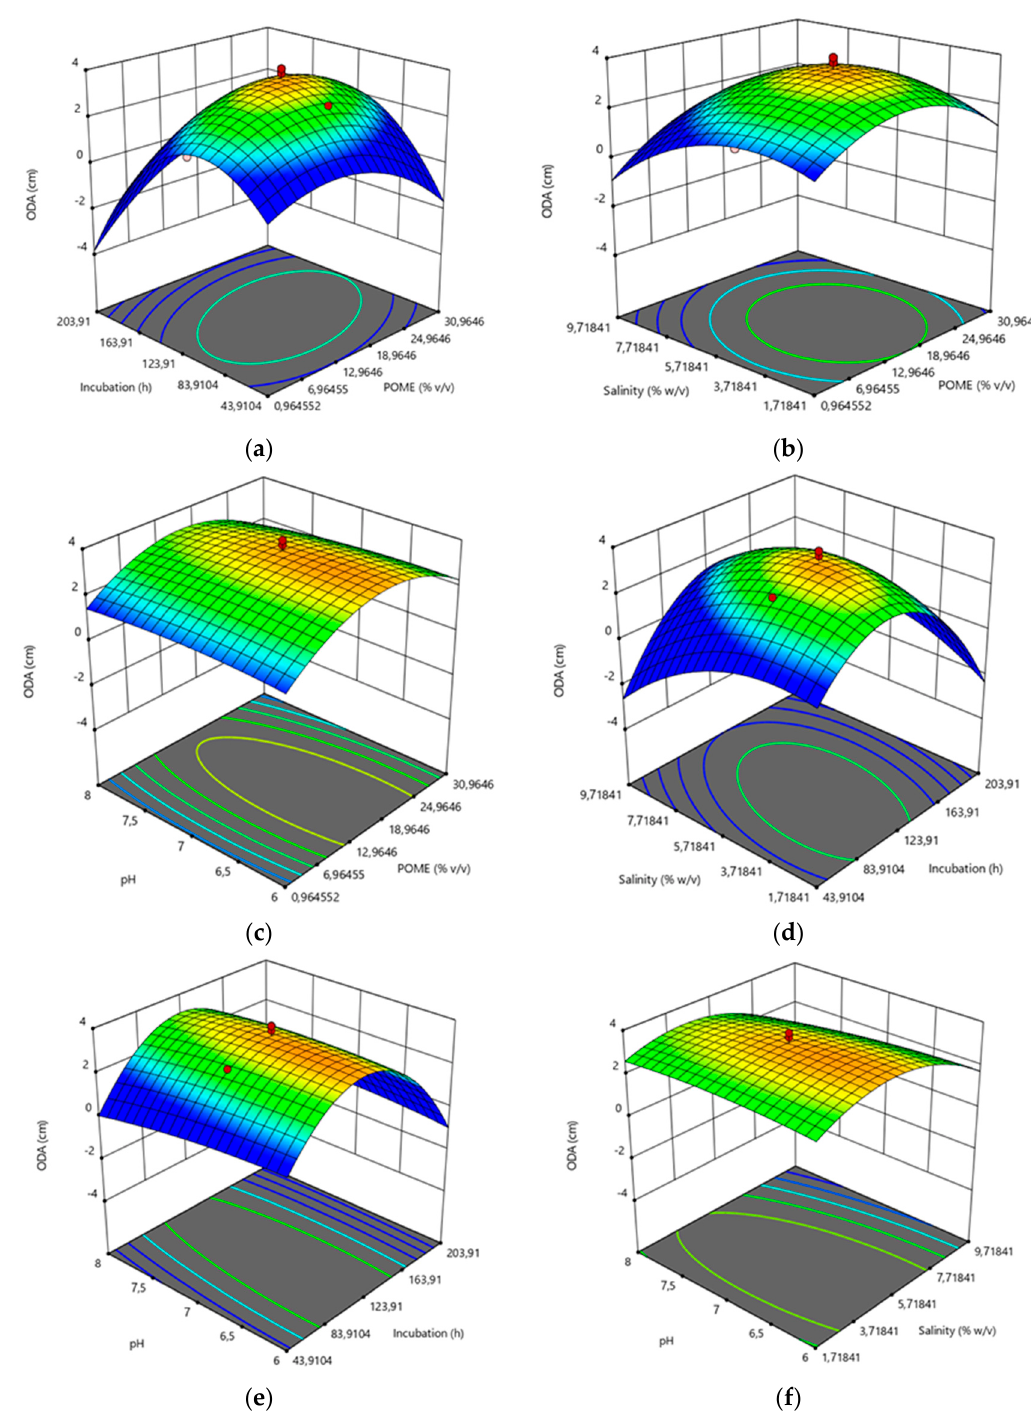
Figure 3. Intervariable relationship in RSM oil displacement area response. ( a ) Incubation and POME concentration, ( b ) NaCl concentration and POME concentration, ( c ) pH and POME concentration, ( d ) NaCl concentration and incubation, ( e ) pH and incubation, ( f ) pH and NaCl concentration.